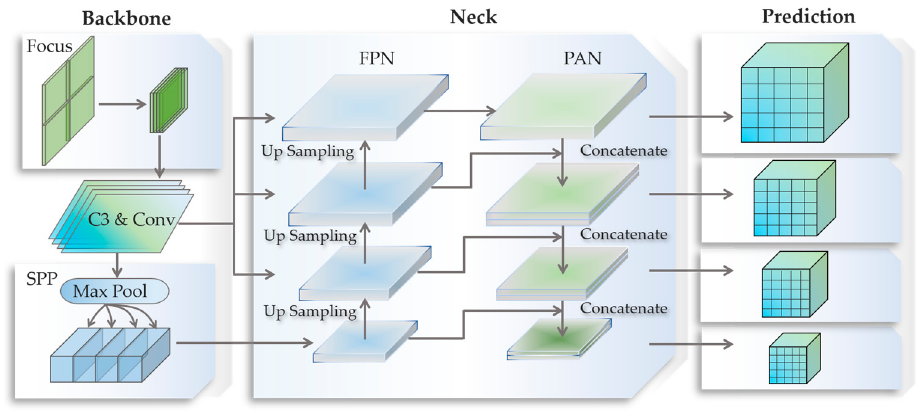
Figure 2. Schematic representation of YOLOv5 architecture.